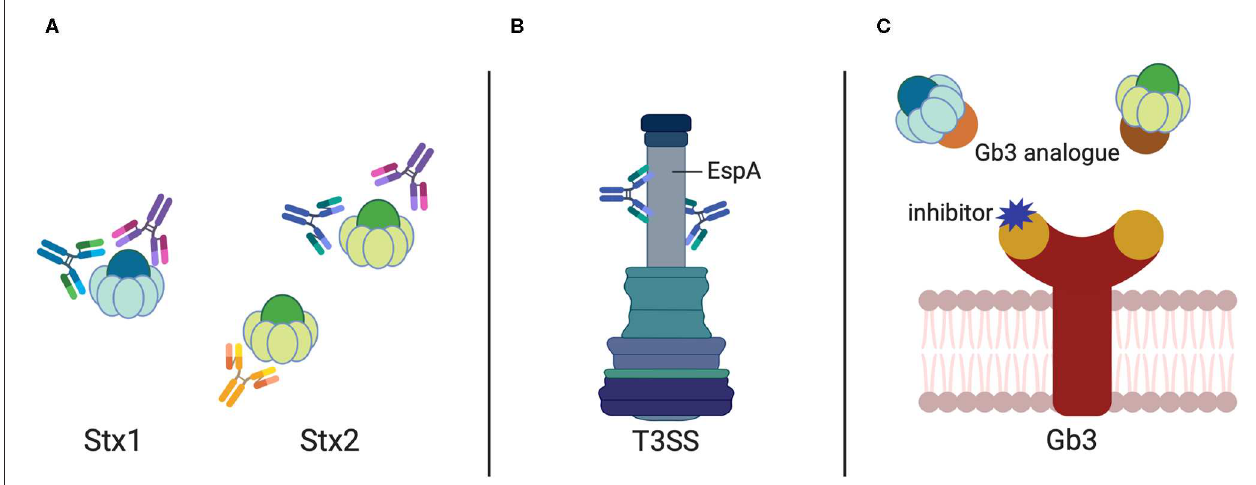
FIGURE 1 | Antibodies and Gb3 analogs against STEC-induced diseases. Antibody targets in STEC treatment include (A) the Shiga toxins (Stx1 and Stx2) and (B) the sheath component EspA of the E. coli Type-3-Secretion System. (C) Analogs to the Stx receptor Gb3 harboring the Stx binding domains (given in brown and orange) sequestering Stx1 and Stx2. Inhibitors blocking the Stx binding site of the Gb3 receptor are illustrated in